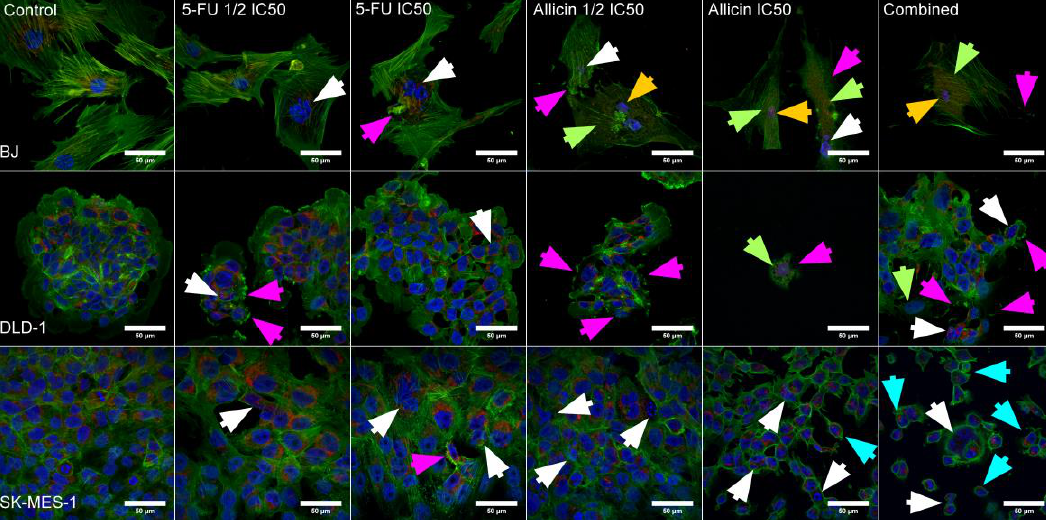
Figure 4. Confocal microscopy analysis of morphological changes induced by allicin, 5-FU, and co-treatment in BJ, DLD-1, and SK-MES-1 cells. The architecture of the cells is highlighted with Mitotracker-Red (mitochondrial networks, red), Phalloidin-FITC (cytoskeleton, green), and DAPI (nucleus, blue). The co-treatment showed a cytotoxic effect on all cell lines. The combination of allicin and 5-FU reduced the cell population in DLD-1 and SK-MES-1. Moreover, the cell shape was modified from normal to round, and gaps between cells were clearly visible (scale bar: 50 µ m, 40 X objective). White arrows, nuclear damage; orange arrows, nuclear shrinkage; magenta arrows, cytoskeleton disruption; green arrows, mitochondrial activity decrease; cyan arrows, apoptotic volume decrease (AVD). BJ, normal fibroblasts; DLD-1, colorectal cancer cell line; SK-MES-1, lung cancer cell line; 5-FU 1 IC50, group treated with half of the 5-FU IC 50 ; 5-FU IC50, group treated with 5-FU IC 50 ; Allicin 1 2 IC50, group treated with half of the allicin IC 50 ; Allicin IC50, group treated with Allicin IC 50 ; combined, group treated with the combination of 5-FU and allicin at half IC 50